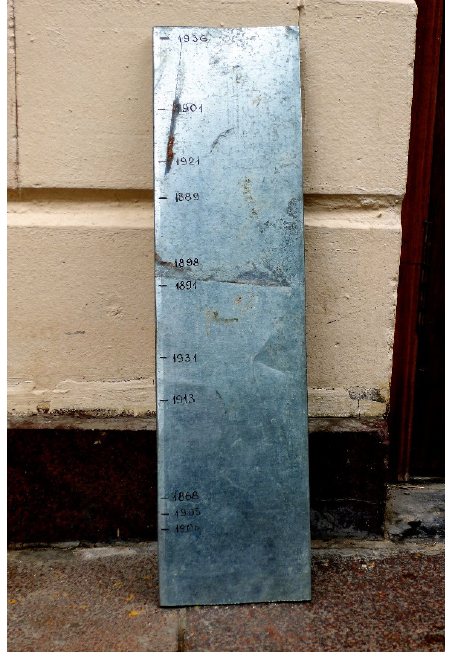
Figure 3. The Nest. Thermography of Maxim Gorky . 1975/2004. Metal, heating element. 30 cm × 90 cm × 20 cm (2004).